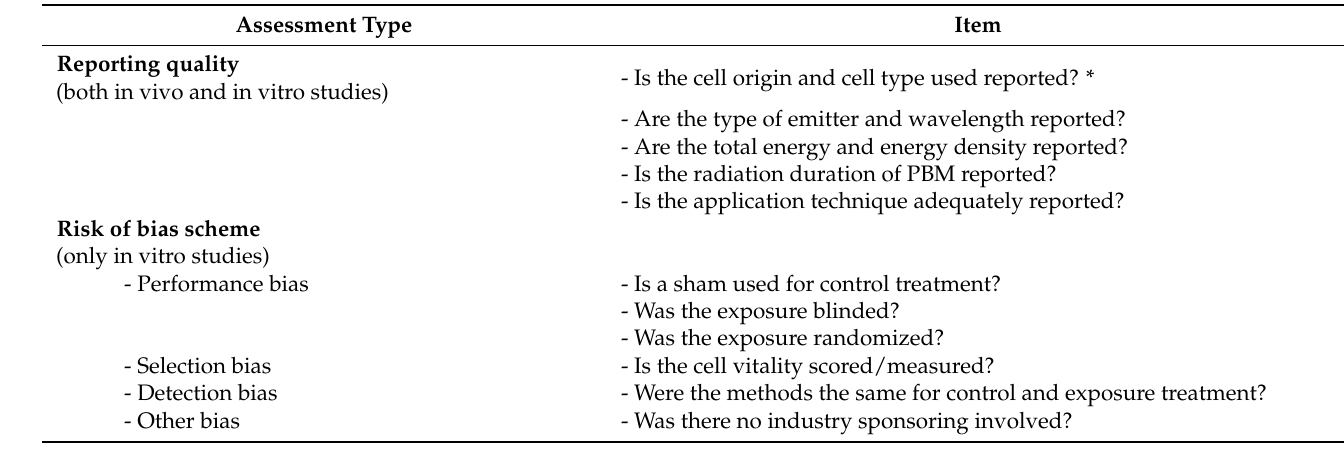
Table 1. Reporting quality scheme (for both in vitro and in vivo studies) and the risk of bias scheme (Only for in vitro studies) [21]. Assessment